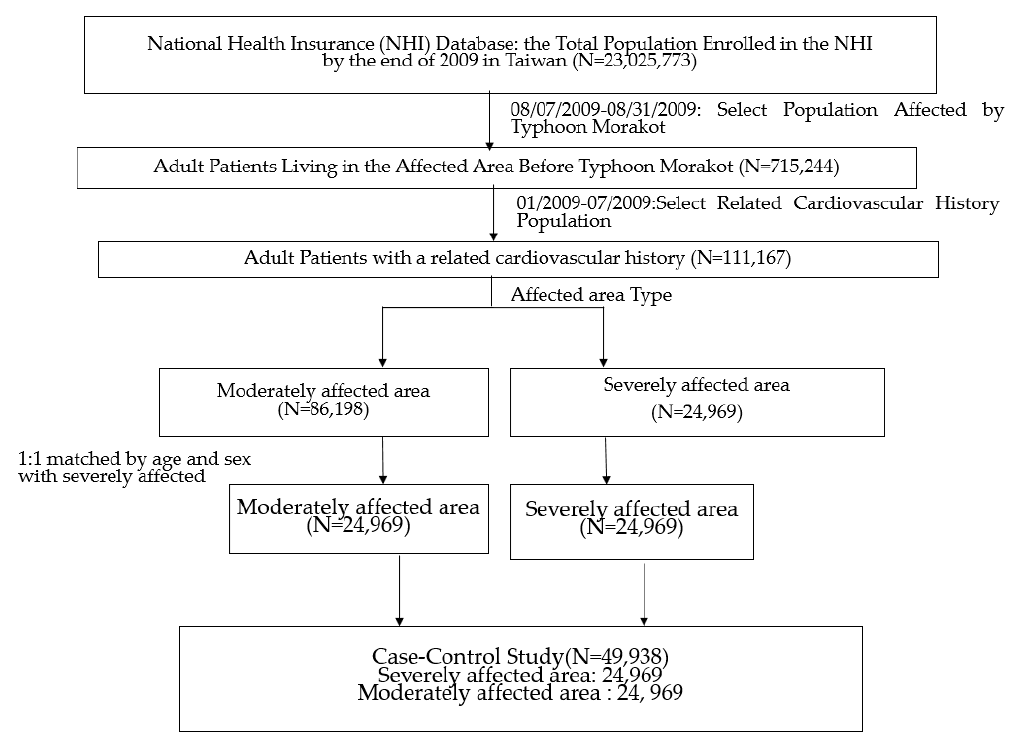
Figure A1. Flow diagram for patients enrolled in this study. Table A1. Affected Townships of Typhoon Morakot.